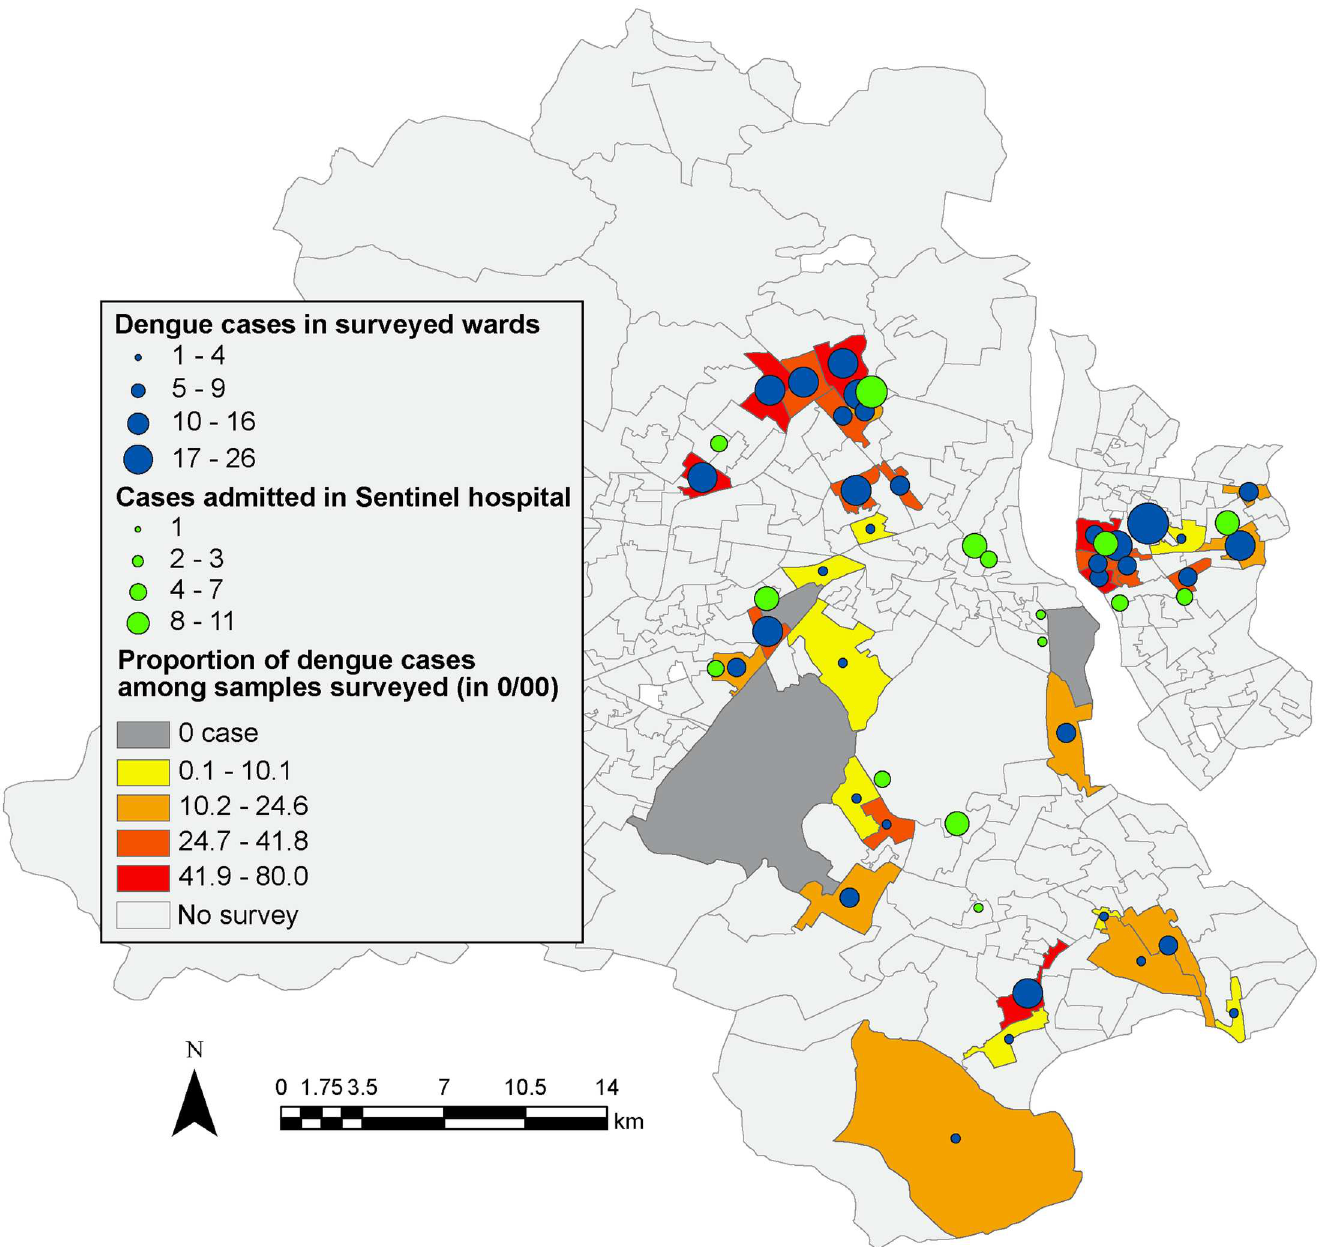
Fig 1. Map of the surveyedarea. The coloursof the wards (from yellow to red) represent the proportion(in thousands) of the number of denguecases related to the surveyedpopulation.Blue circles represent the total number of confirmeddenguecases in the survey. Green circles represent dengue cases that have been diagnosed in a sentinel